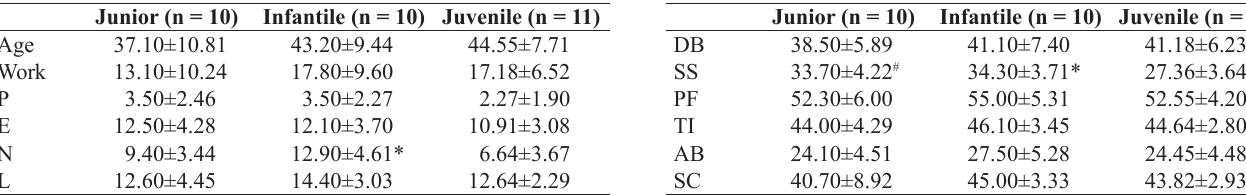
Table 3. Mean and standard deviation of the variables analyzed and the coaches’ performance